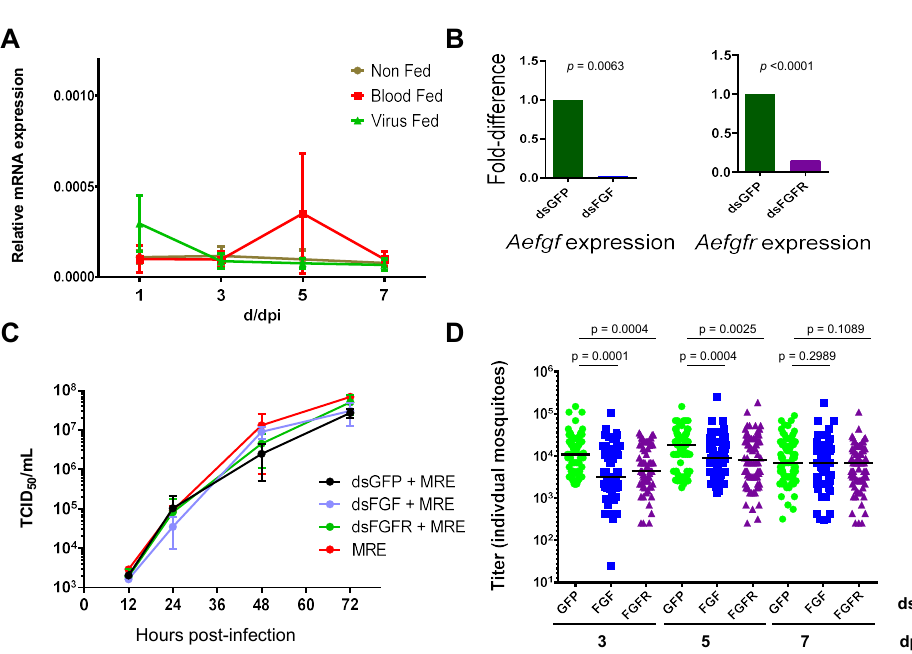
Figure 1. E ff ect of silencing AeFGF or AeFGFR expression on SINV replication in mosquitoes. ( A ) Ingestion of a blood meal, with or without SINV, does not a ff ect FGF expression in midgut at the mRNA level. Two day-old adult female Ae. aegypti were either fed only raisins and water (Non Fed), fed a blood meal mixed 1:1 with cell culture media (Blood Fed), or fed a blood meal mixed 1:1 with cell culture media containing SINV (MRE5 (cid:48) 2J strain or MRE; Virus Fed). At 1, 3, 5, and 7 days later, midguts were harvested and RNA from pools of 10 midguts was used in qRT-PCR assays to determine Aefgf mRNA levels relative to rpS7. The combined results of four independent experiments are shown (mean +/ − standard error). There were no significant di ff erences detected between non-fed and blood-fed ( p = 0.42), non-fed and virus-fed ( p = 0.60), or blood-fed and virus-fed ( p = 0.77) by paired t -test. ( B ) Aefgf and Aefgfr can be knocked down in Aag2 cells. dsRNAs corresponding to Aefgf , Aefgfr , or gfp were added to Aag2 cells and 24 h later, cells were harvested and total RNA was used for qRT-PCR. Values were normalized using the rpS7 gene and analyzed by unpaired t -test. ( C ) Silencing Aefgf or Aefgfr does not a ff ect SINV replication in Aag2 cells. Either no dsRNA or dsRNAs corresponding to Aefgf , Aefgfr , or gfp were added to Aag2 cells and 24 h later cells were infected with MRE. Virus titers were determined at the times indicated. The data shown are the results of two replicates ( +/ − standard error) and significance was analyzed by repeated measures one-way ANOVA, which determined no significant di ff erences between treatments ( p = 0.313). ( D ) Knocking down Aefgf or Aefgfr has a negative e ff ect on SINV titers following oral infection. Two-day old female Ae. aegypti were injected with either gfp , Aefgf, or Aefgfr dsRNA and 48 h later given a blood meal containing MRE. Mosquitoes were harvested and individually titered at 3, 5, and 7 days post blood meal. A total of between 66 and 83 mosquitoes were sampled for each treatment and time point. Significance was determined by Mann-Whitney